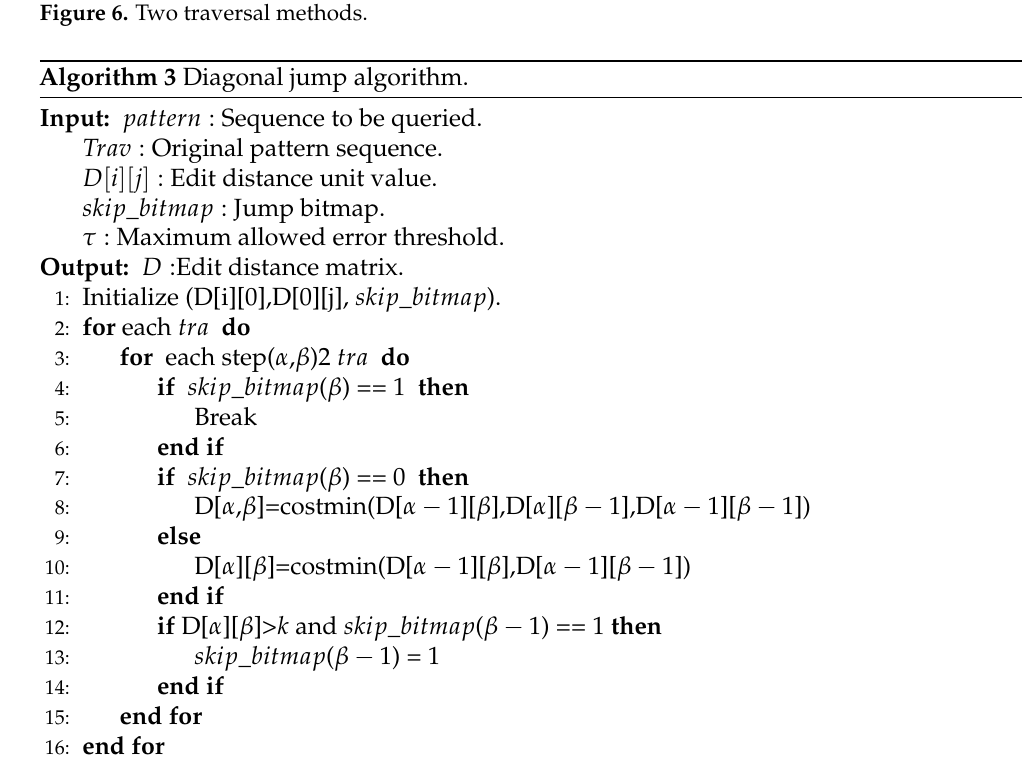
Figure 6. Two traversal methods. Algorithm 3 Diagonal jump